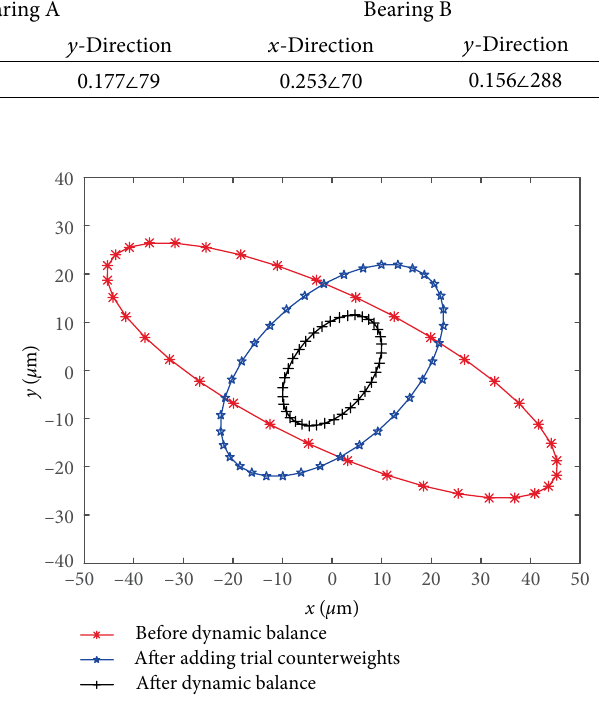
Figure 11: Measured journal surface temperature curves at bearing A.